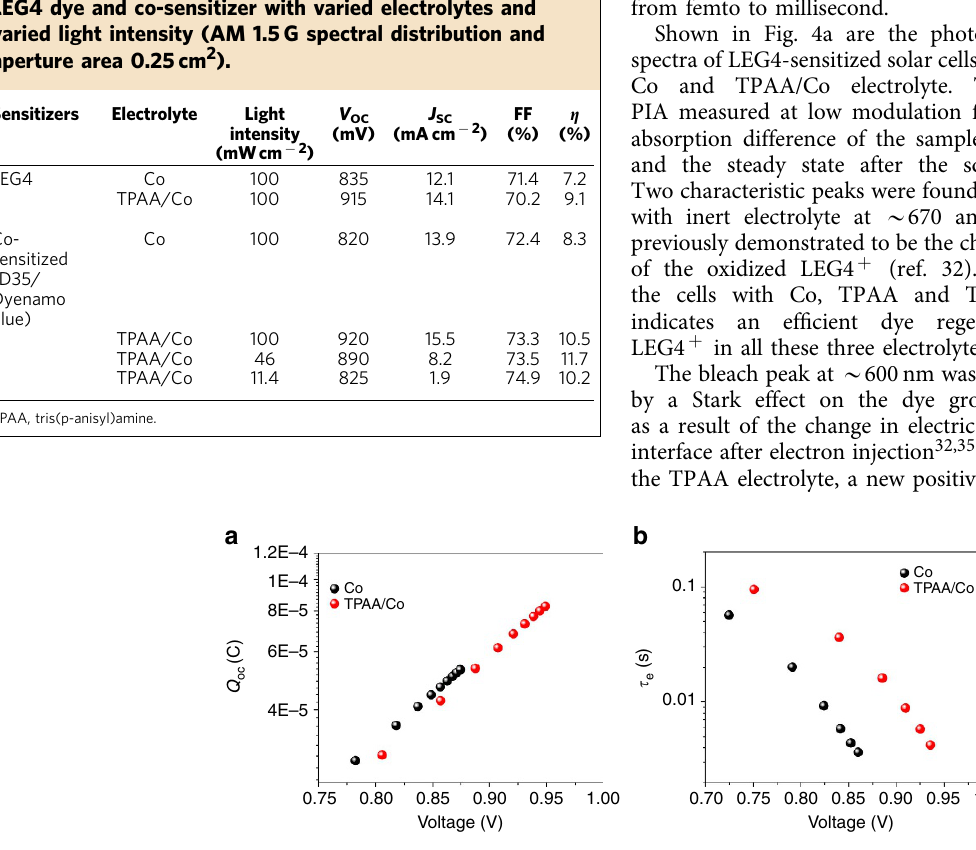
Figure 3 | Charge extraction and electron lifetime. Charge extraction ( a ) and electron lifetime ( b ) measurements as a function of the voltage under open circuit conditions for DSSCs sensitized with LEG4 dye employing the standard cobalt and TPAA/Co electrolyte.